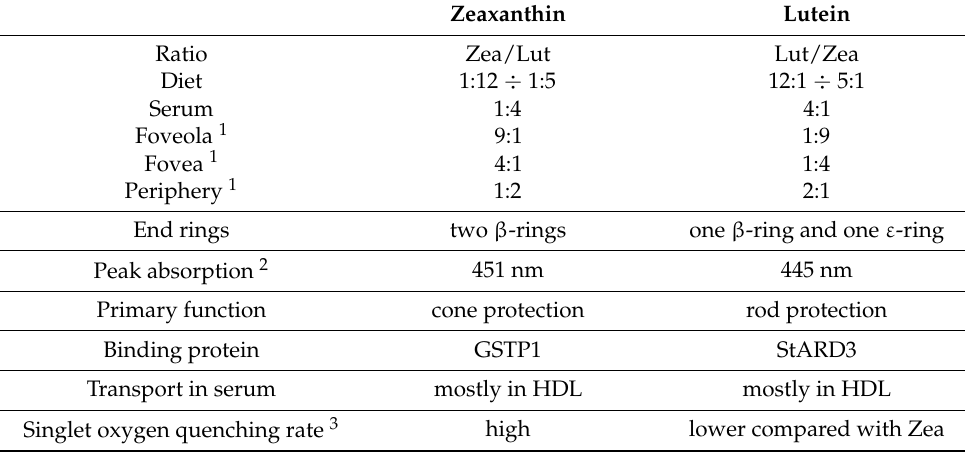
Table 3. The comparison between zeaxanthin and